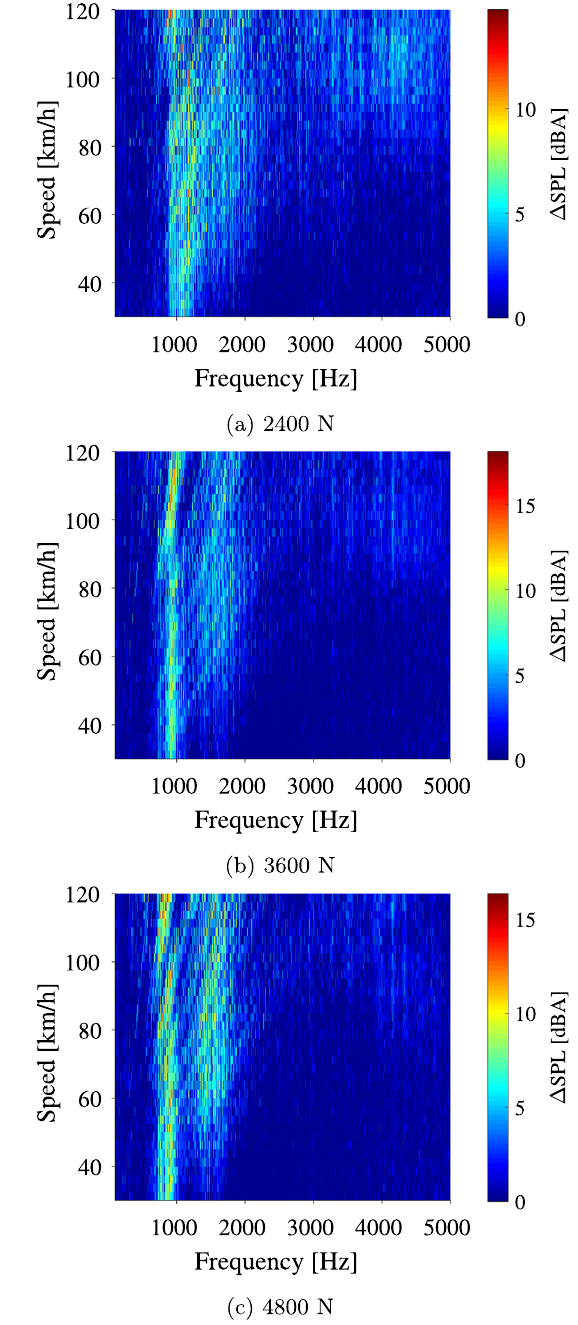
Figure 6. Spectral analysis of the groove resonance noise of the summer tire on the asphalt 0/5 at the trailing edge